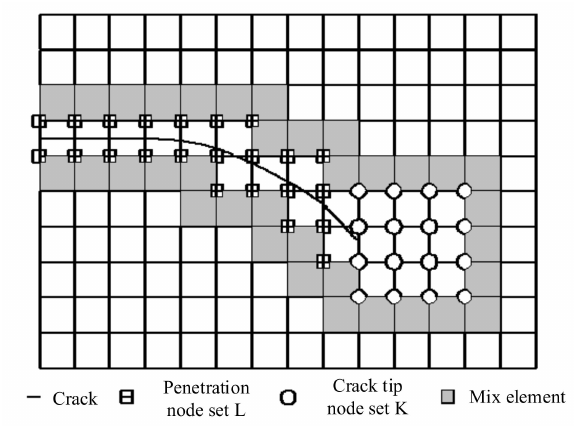
Figure 1. Two level sets of